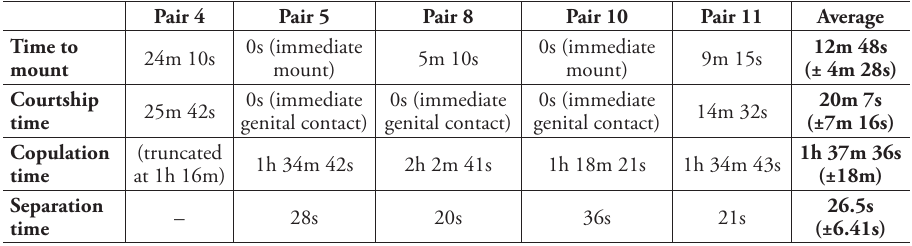
Table 3. Mating duration for the five (of eleven) successful mating trials. Note that pair 4 lacks intromit- tent and separation time as video recording was truncated during the mating experiment. Consequently, these two values, as well as those with a 0s are omitted from calculating average